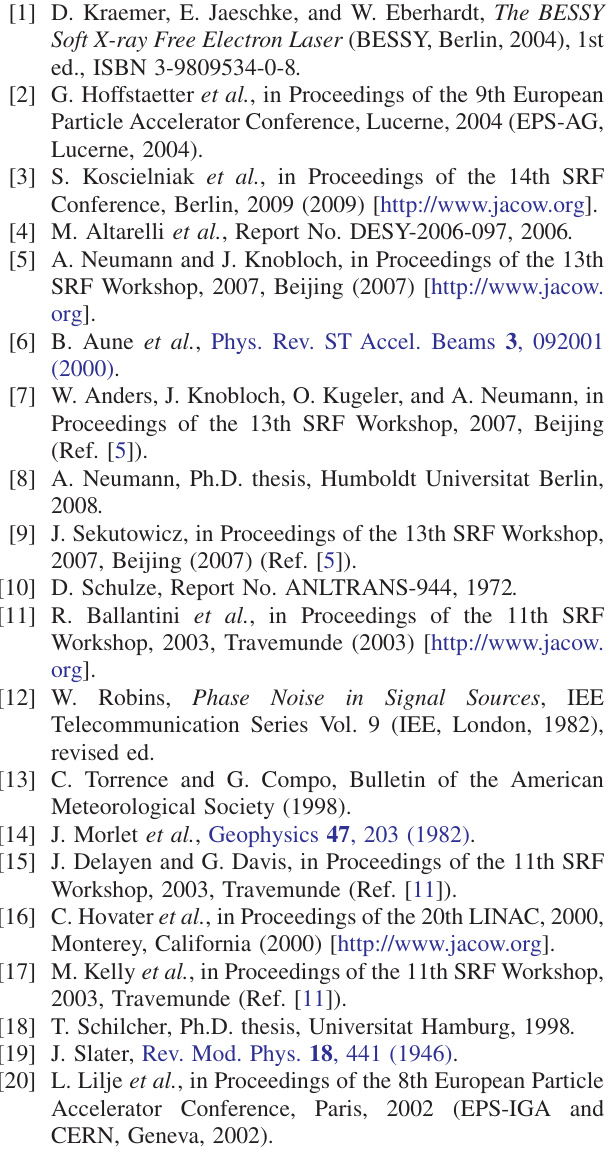
algorithm and low-frequency feedback showed a success- ful compensation under varying conditions. The total de- tuning was reduced by a factor ranging from 2–7.